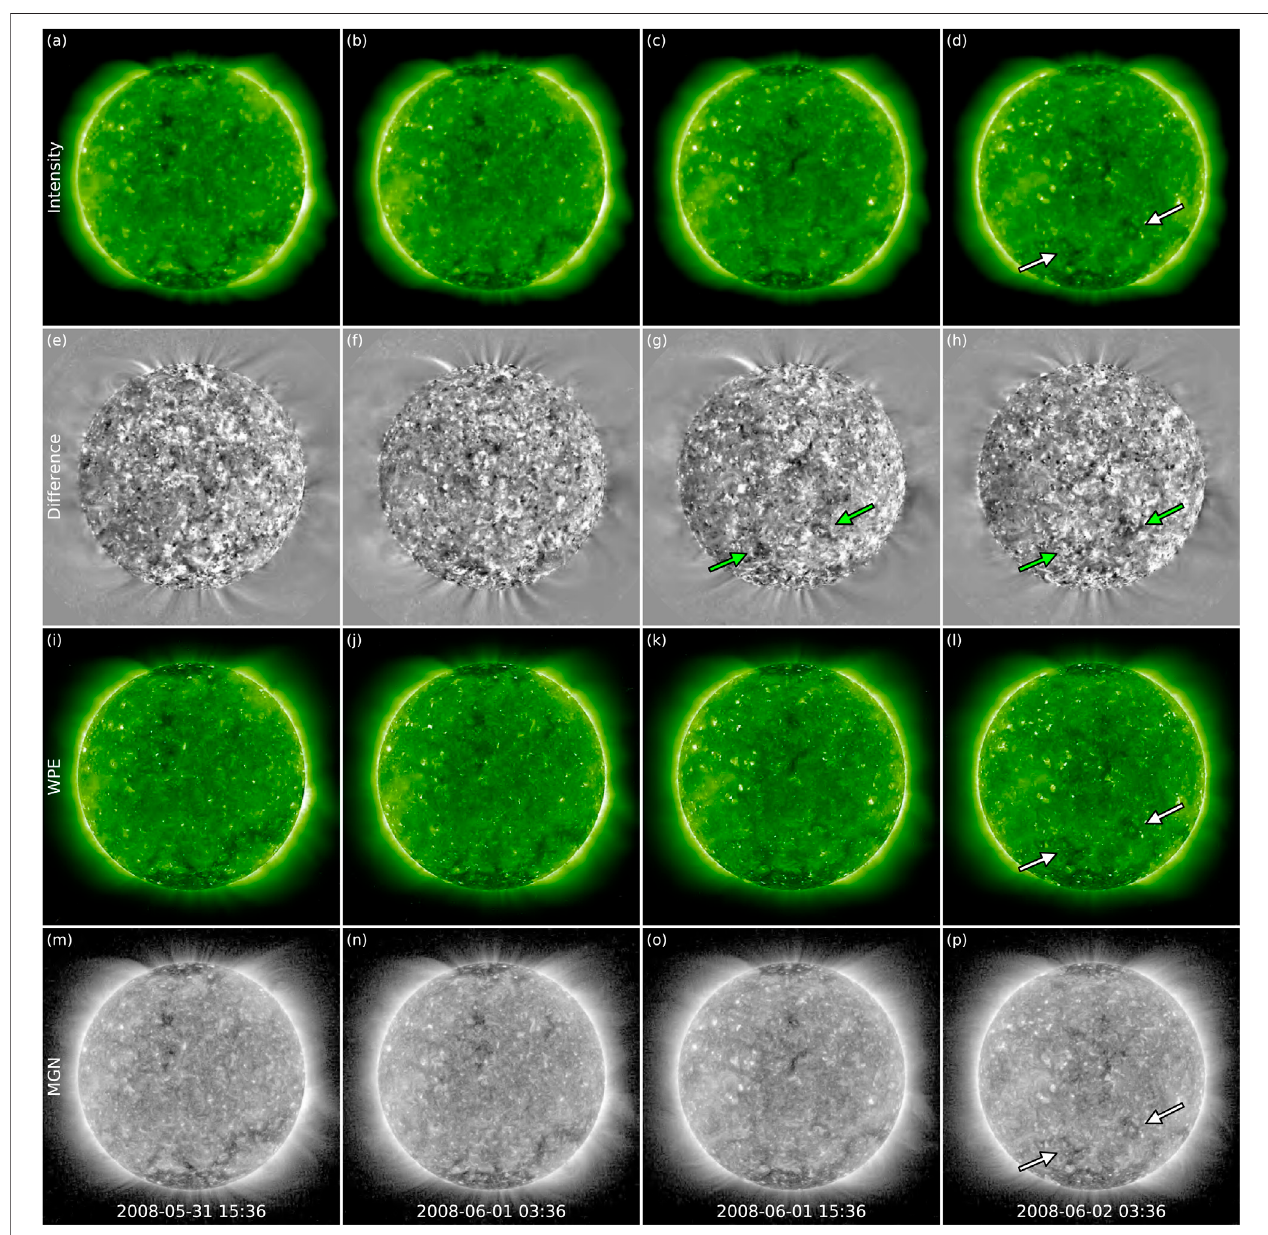
FIGURE 1 | Imaging techniques applied to the 2008 June 1 CME (Event 1). STEREO/SECCHI/EUVI-B 195Å images are shown at four different times and processed with four different methods. (A – D) Intensity images. (E – H) Difference images with fi xed Δ t (cid:2) 12 h. (I – L) WPE-processed images. (M – P) MGN-processed images. Two faint dimmings are indicated with arrows (see text for